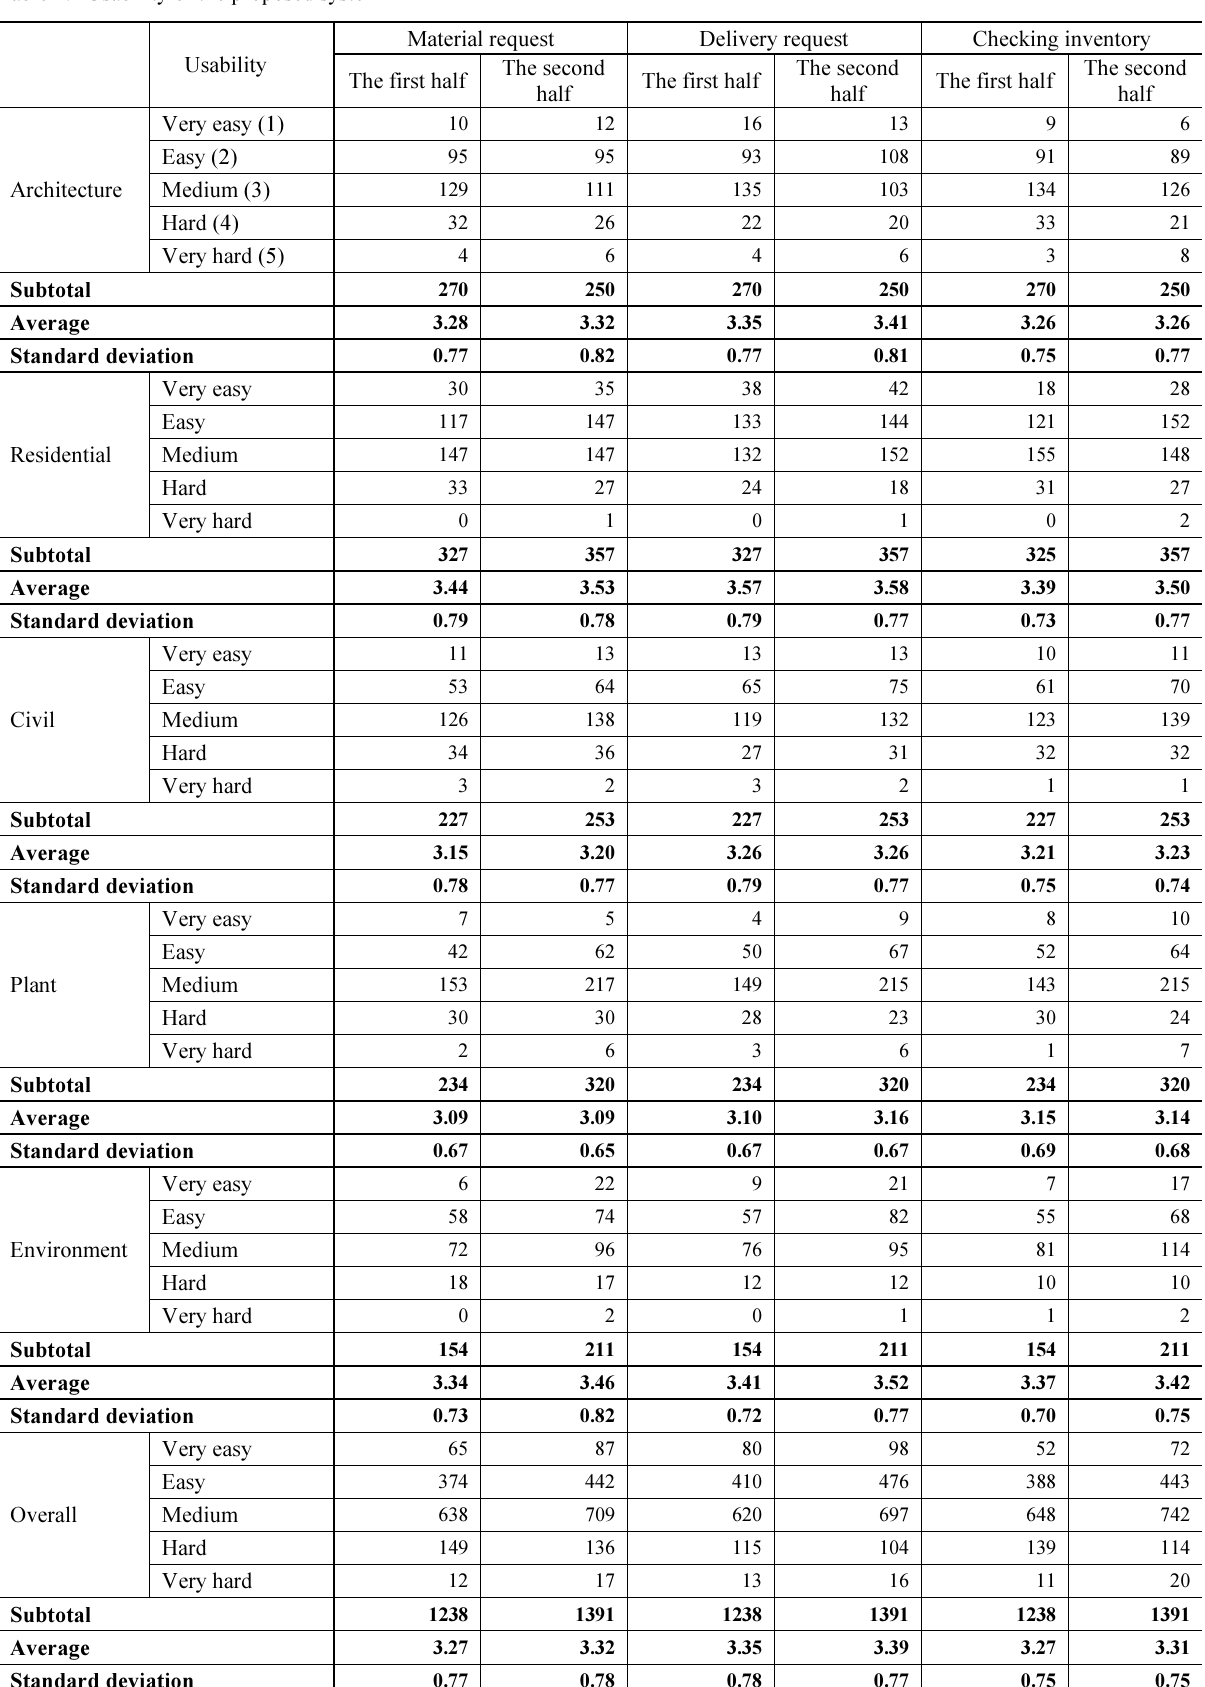
Table 2. Usability of the proposed